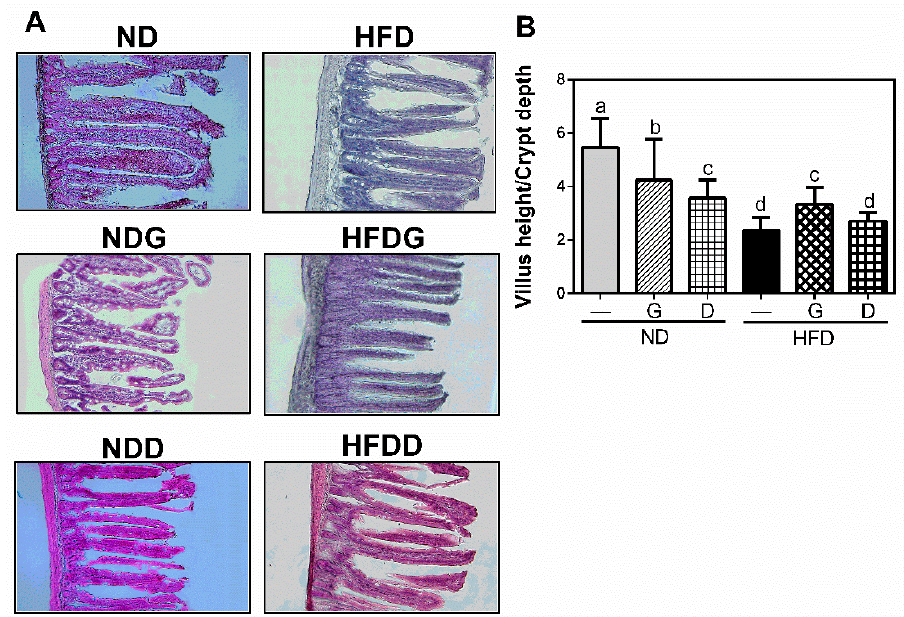
Figure 5. Morphology of terminal ileum ( A ) and the ratio of villus height to crypt depth ( B ). Values are presented as means ± SD of 16 histomorphological points of each group. Columns with different letters significantly differ ( p < 0.05).